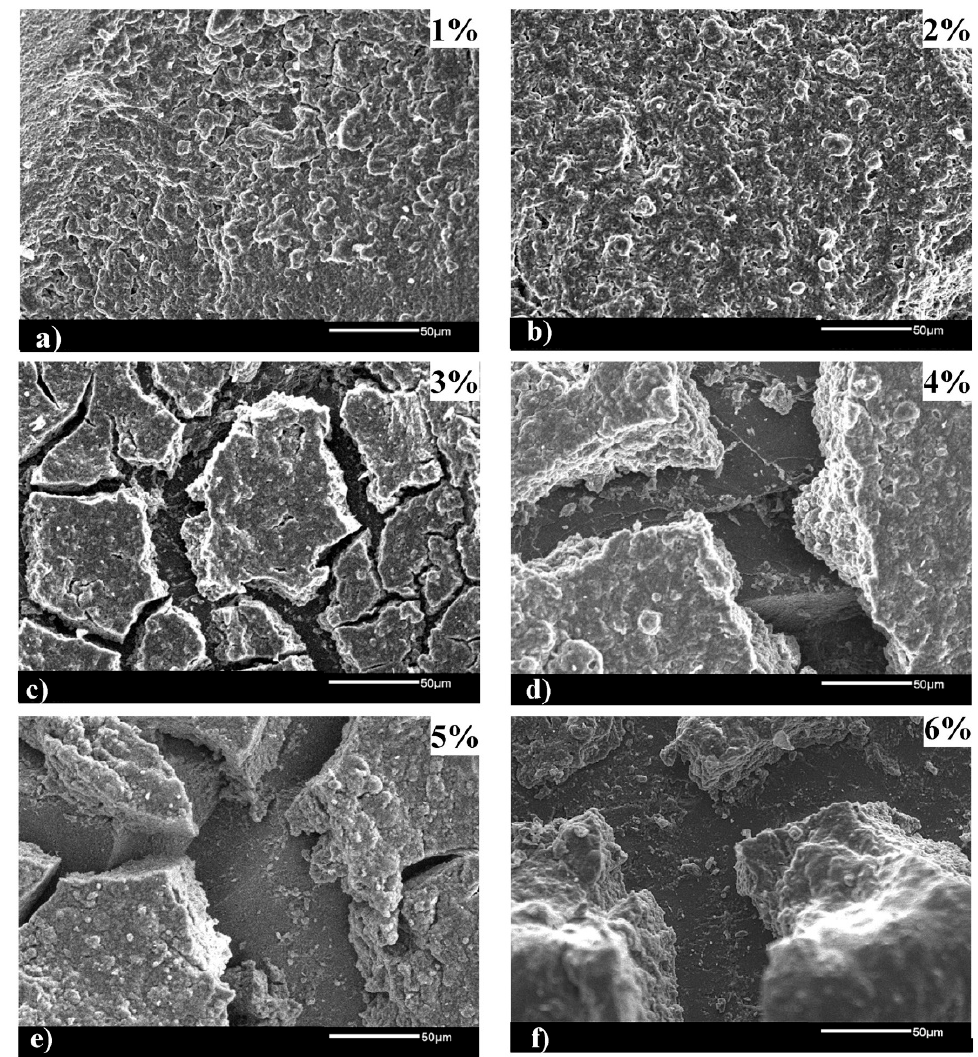
Figure 8. SEM images of marble surfaces coated with siloxane with SiO 2 nano-particles at increasing loading (from ( a ) to ( f )). In the upper right corner of each image the nano-particles’ concentrations (wt %) is reported. Reprinted with permission from [37]. Copyright 2016 Elsevier.